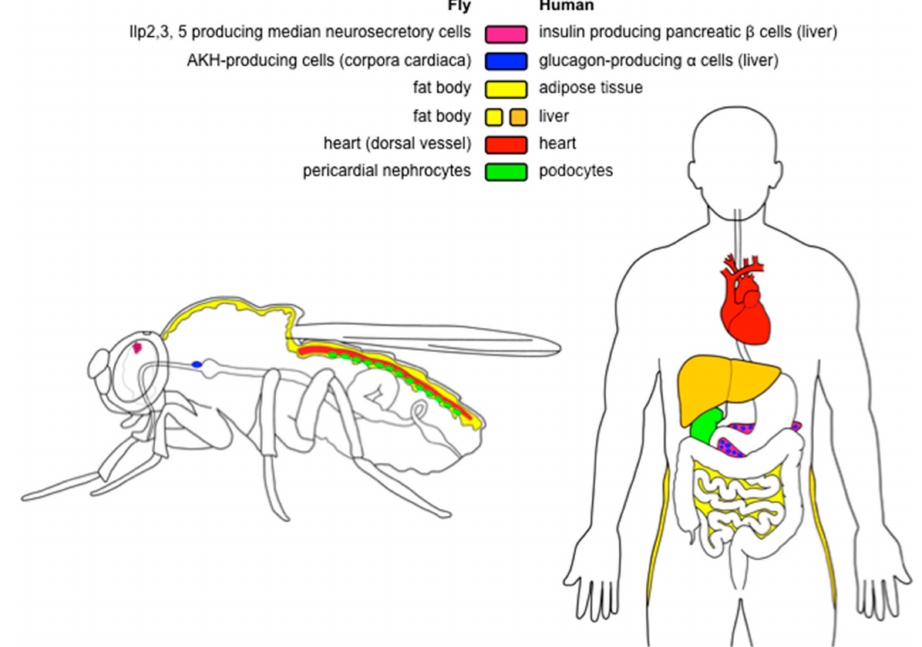
Figure 1. The organs that regulate energy homeostasis and may link obesity to lifespan. The tissues that share similar functions in Drosophila and humans are depicted in the same colors. The median neurosecretory cells of the fly brain produce Insulin-like peptides 2, 3, and 5 (Ilp2, 3, and 5), which act similarly to human insulin produced in the pancreatic beta cells. The Drosophila analog of human glucagon—adipokinetic hormone—is produced in the corpora cardiaca, whereas human glucagon is produced in the alpha cells of the pancreas. In the fly, fat and glycogen are stored in the fat body, which is an organ fulfilling the functions of the human adipose tissue and liver. The dorsal vessel (fly heart) is a linear tube that pumps hemolymph into the open circulatory system, and is considered as a functional counterpart of the human heart. Pericardial nephrocytes are cells that filter fly hemolymph, and share morphological and functional features with podocytes, cells of the kidney glomerulus. See the text for further details.